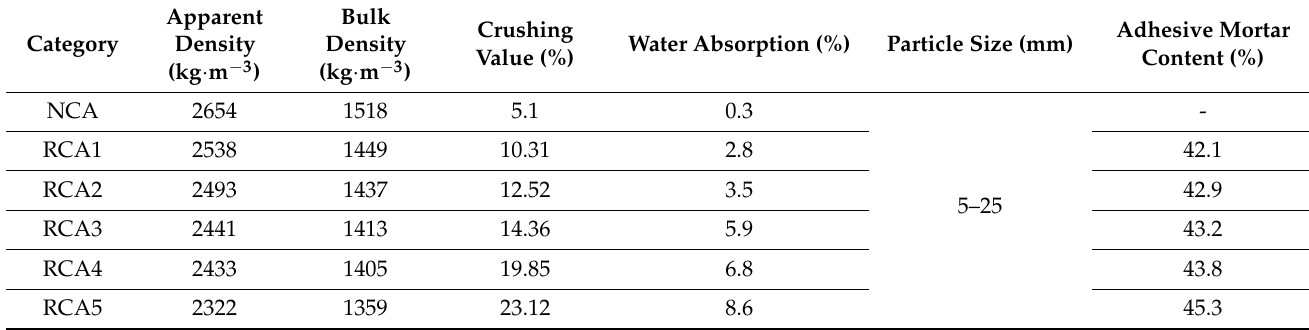
Table 1. The physical properties of NCA and RCAs.